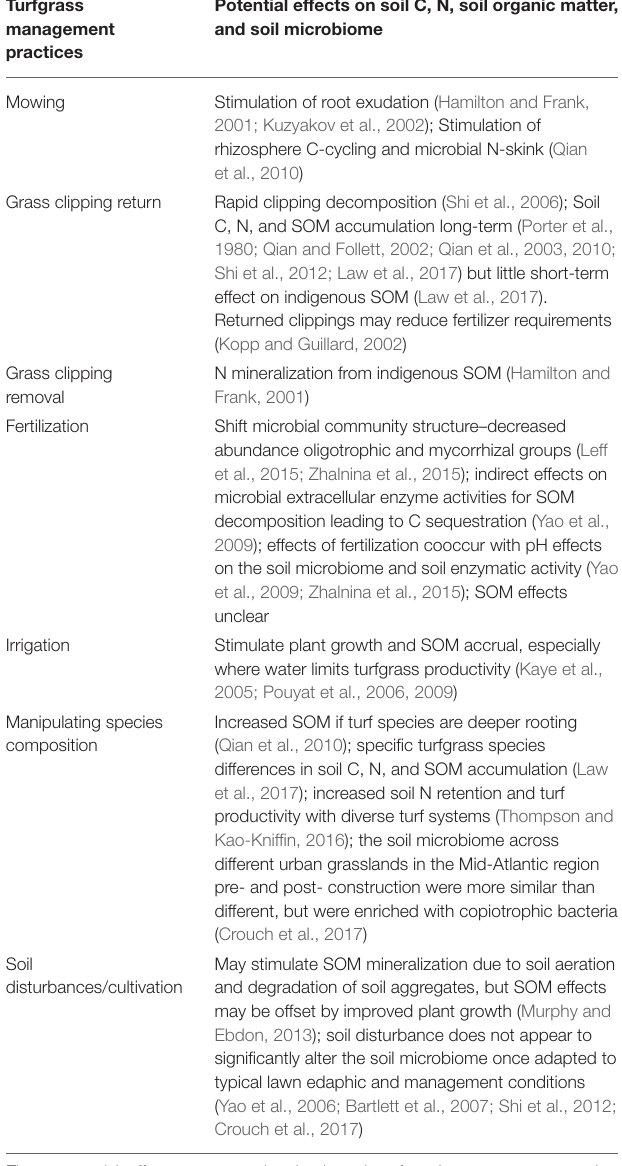
TABLE 1 | Common turfgrass management practices their effects on soil C, N, soil organic matter (SOM), and the soil